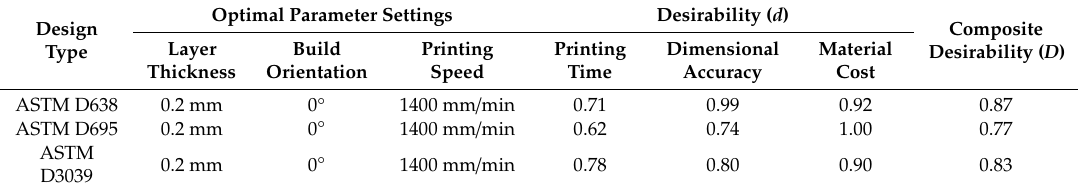
Table 12. Optimal parameter settings derived by multiple response